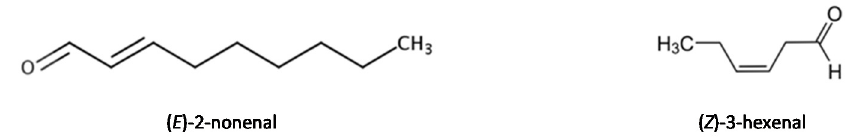
Figure 12. Chemical structure of ( E )-2-nonenal and ( Z )-3-hexenal. Figure 12 . Chemical structure of ( E )-2-nonenal and ( Z )-3-hexenal.